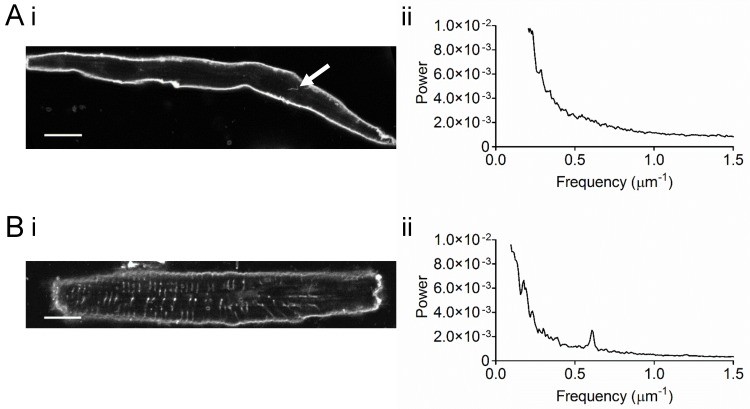
Di-8-ANEPPS-stained isolated atrial and ventricular myocytes.A) Representative image of a di-8-ANEPPS-stained isolated atrial myocyte (i) and corresponding power spectrum (ii). Data are representative of 10 cells from 3 pigs. B) Representative image of a di-8-ANEPPS-stained isolated ventricular myocyte (i) and corresponding power spectrum (ii). Arrow indicates staining of t-tubule network. Scale bars represent 12 μm. Data are representative of 4 cells from 1 pig. The mean (±SEM) of the frequency corresponding to the peak was 0.588±0.004 μm-1 and the mean amplitude was 2.45×10−3±7.12×10−4 (n = 4).